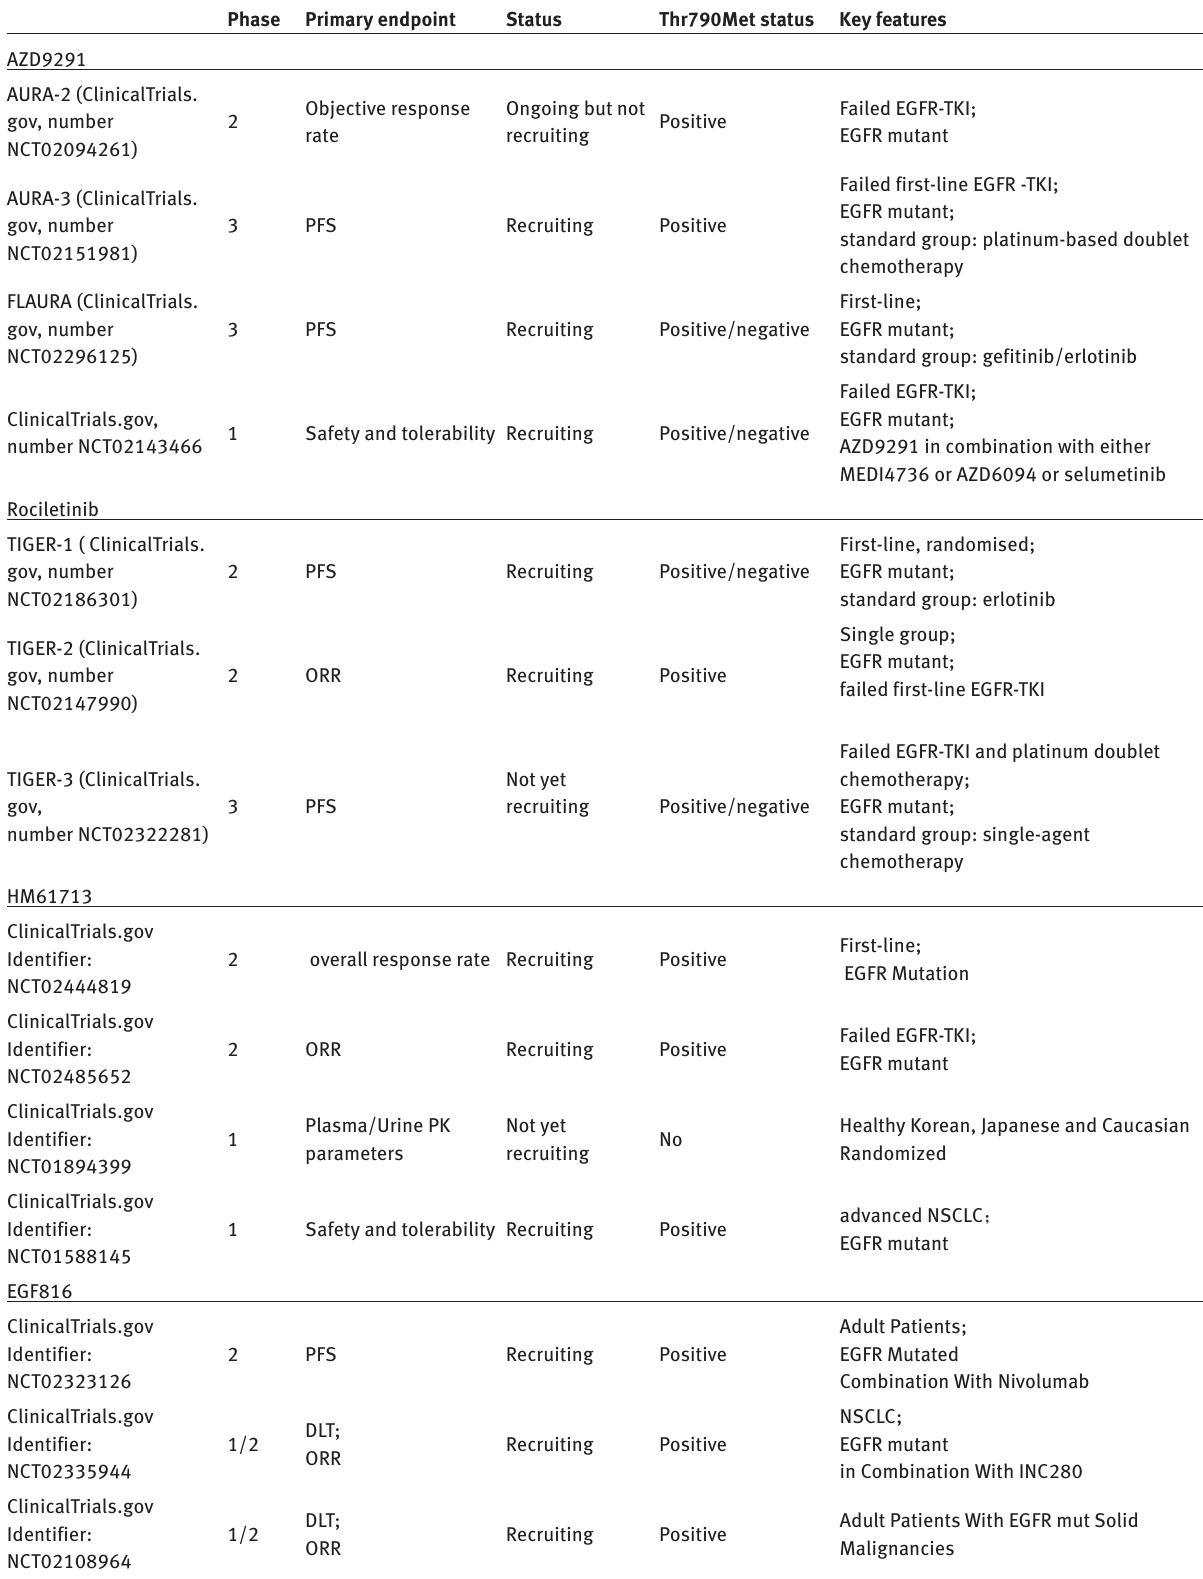
Table 2: Ongoing clinical studies for third-generation tyrosine kinase inhibitors. edited from